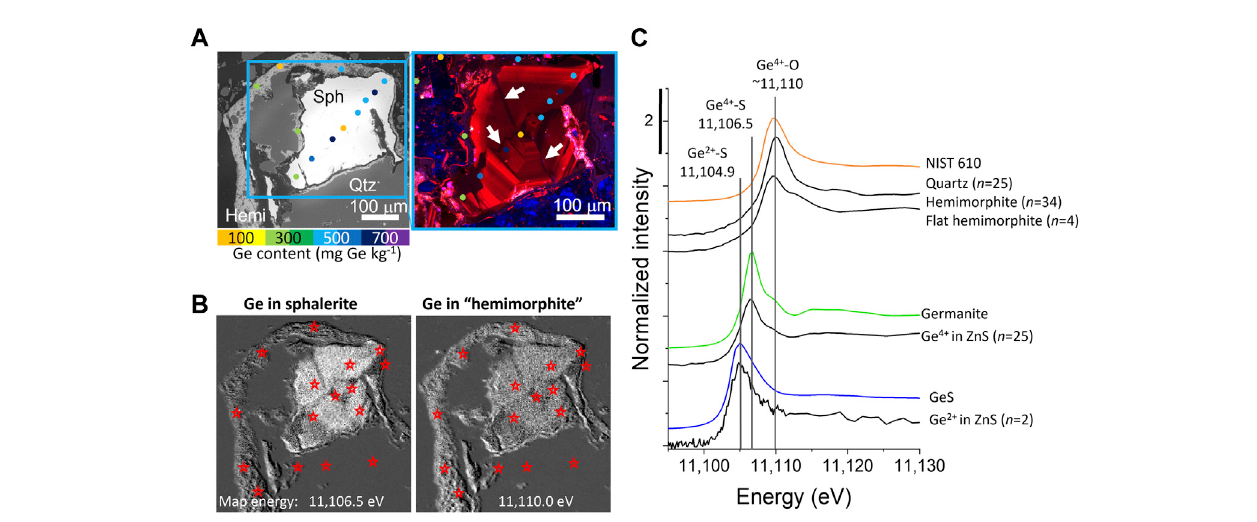
FIGURE 4 Ge speciation in sphalerite, quartz, and hemimorphite. (A) SEM-BSE and cathodoluminescence images from a representative location from a Tar Creek Mahutskasample(CLregionslightlysmaller,seeblueboxinBSEimage).Microprobelocationsshownwithcoloreddots,withcolorindicatingGecontent,and low CL regions indicated with white arrows. (B) Phase map highlighting the distribution of Ge in sphalerite and Ge in hemimorphite (hemimorphite is in quotations below because Ge in sphalerite has a non-zero absorbance at this energy). In these gray-scale images, white corresponds with higher Ge- containing phase, whereas black indicates the absence of Ge-containing phases. Red stars indicate locations where Ge μ -XANES spectra were collected (individual spectra not shown). (C) μ -XANES spectra of Ge 4+ in quartz, typical hemimorphite and a few hemimorphite spectra with a fl at white line, Ge 4+ in sphalerite, and, rarer, Ge 2+ in sphalerite. Reference spectra (colored lines) are shown with characteristic maximum absorption energies